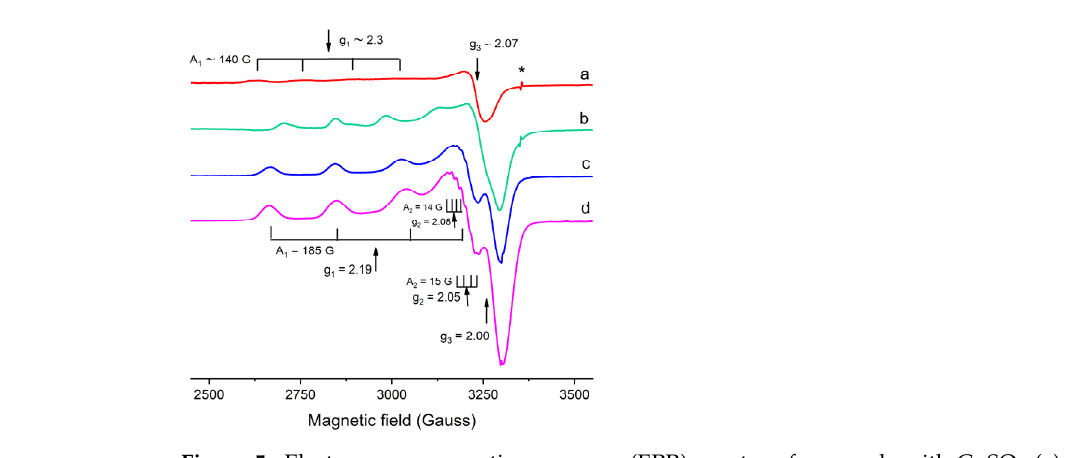
Figure 5. Electron paramagnetic resonance (EPR) spectra of agar gels with CuSO 4 ( a ) and with additives: EDTA ( b ), ALA ( c ), TAC ( d ), all at pH 10.0. The asterisk * indicates a signal probably due to impurities present in the agar network. Table 2. Parameters and attribution of electron paramagnetic resonance (EPR) signals observed at 123 K in agar gels. Solute g 1 ± 0.01 g 2 ±